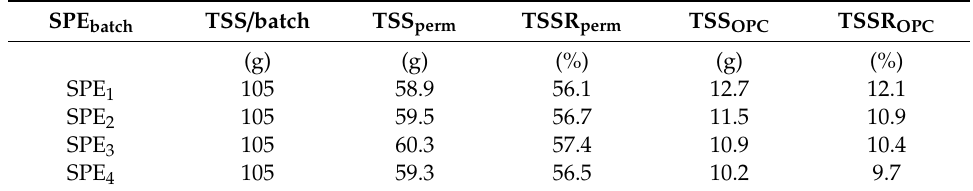
Table 1. Total soluble substances per batch (TSS / batch), total soluble substances recovered in the permeate (TSS perm ), total soluble substances recovered in the permeate and referred to 100 g of TTS / batch (TSSR perm ), total soluble substances recovered in the OPC fraction (TSS OPC ) and total soluble substances recovered in the OPC fraction and referred to 100 g of TTS / batch (TSSR OPC ) after solid-phase extraction (SPE) of the ultrafiltered GSE permeate.